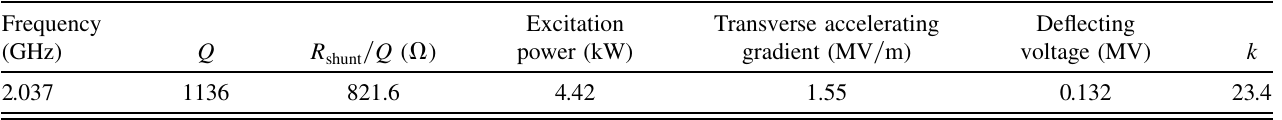
TABLE II. Key performance metrics of deflecting structure.